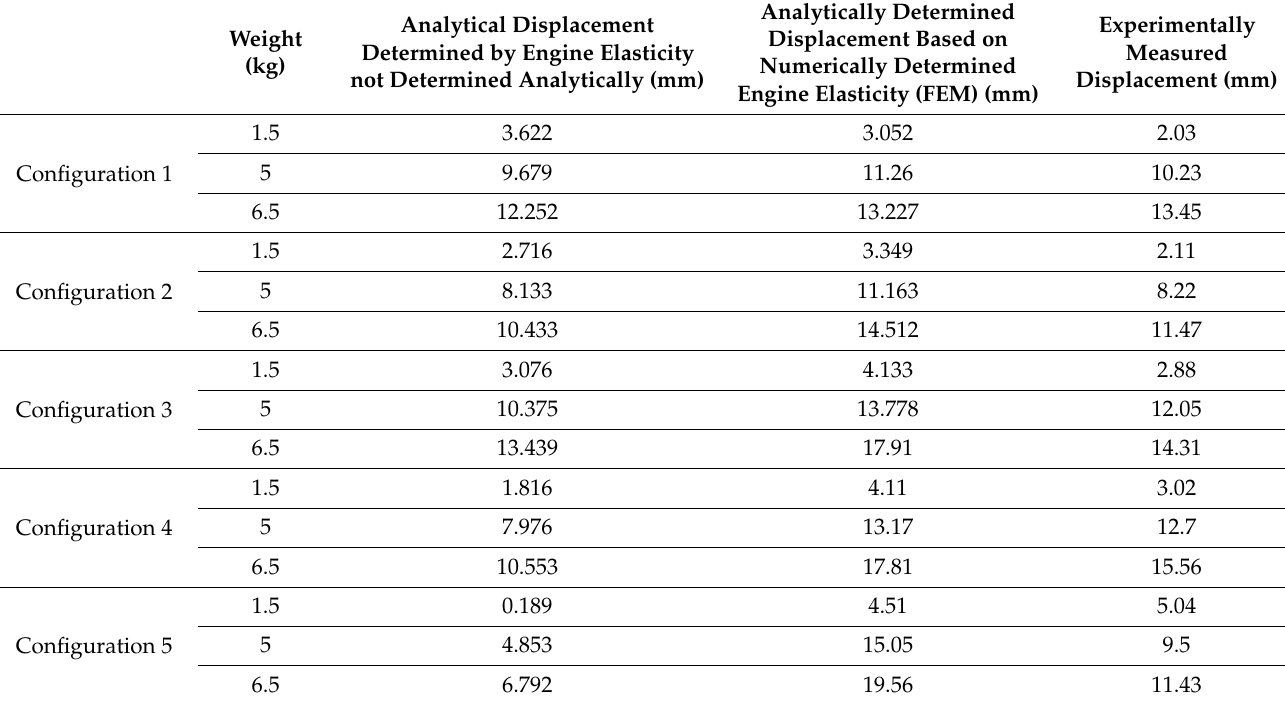
Table 9. Effector displacement calculated based on the axial deformations of the motors, considering them as elastic elements by the analytical method, and numerically and experimentally measured